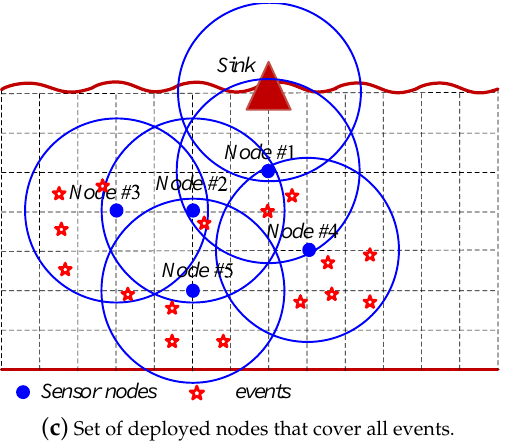
Figure 3. Schematic diagram of the movement process of